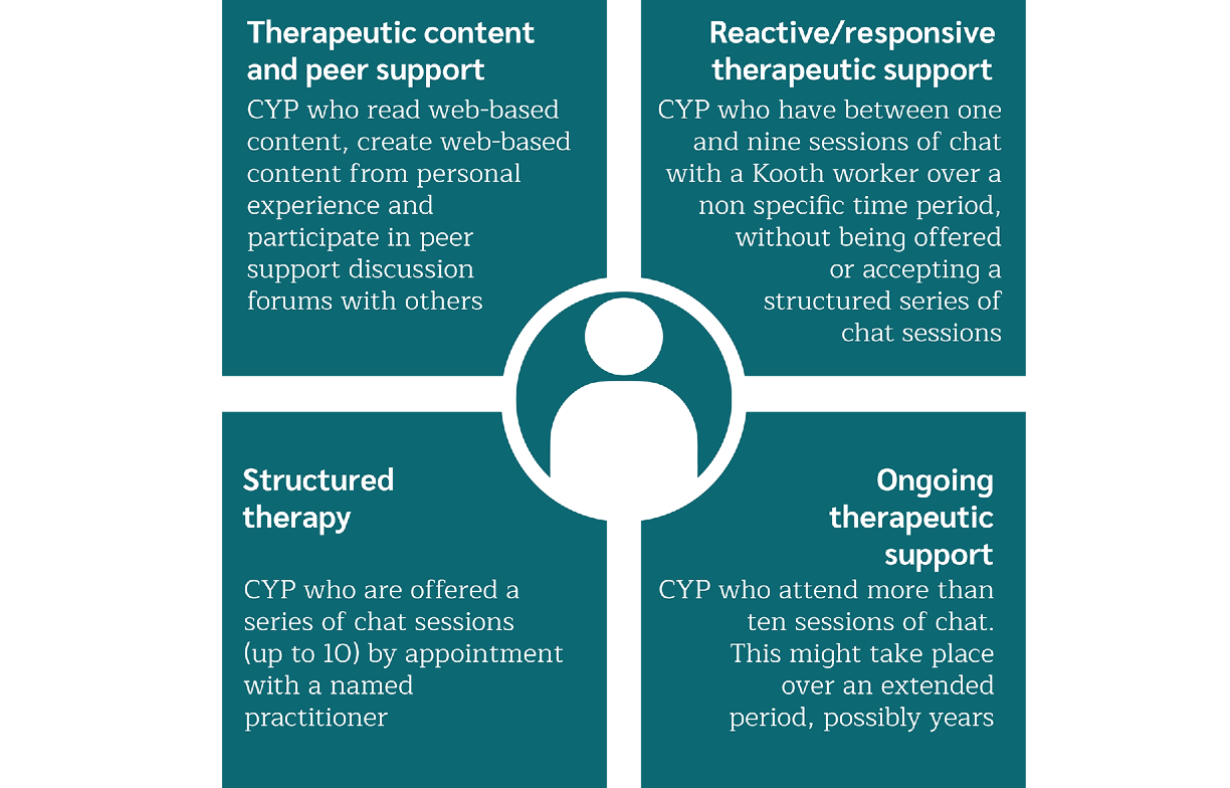
Figure 1. Descriptions of the 4 service pathways for Kooth. CYP: children and young